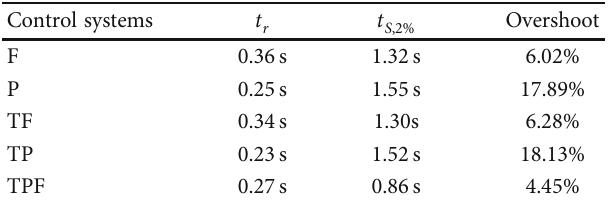
Figure 4: Longitudinal motion of Aero-WIG in wind axes. Table 2: Results of di ff erent control systems recovering from a 1m disturbed altitude (ascent).